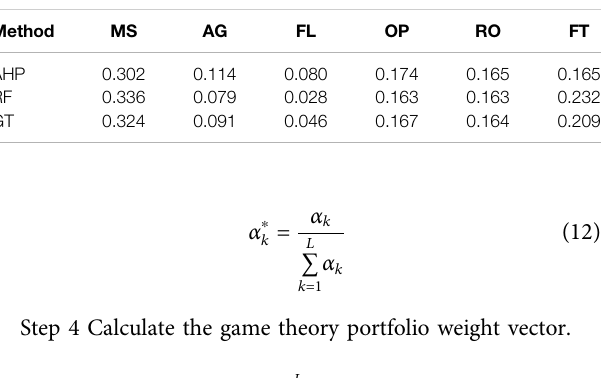
TABLE 9 | Combination weights of vulnerability